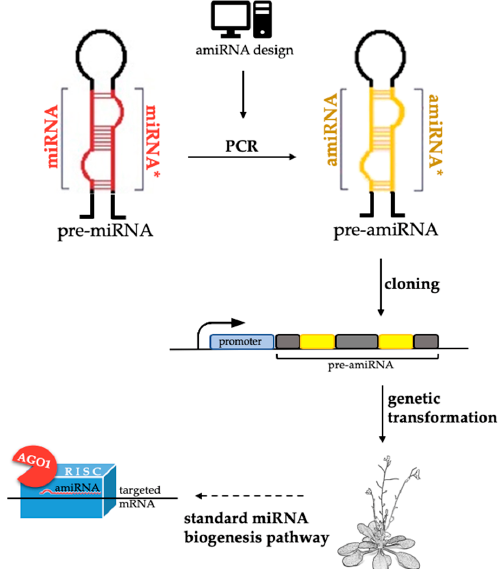
Figure 4. A schematic representation of the artificial miRNA (amiRNA) design, introduction into the plant genome and mode of action. pre-miRNA: Precursor-miRNA; pre-amiRNA: Precursor-amiRNA; AGO: ARGONAUTE; RISC: RNA Induced Complex.